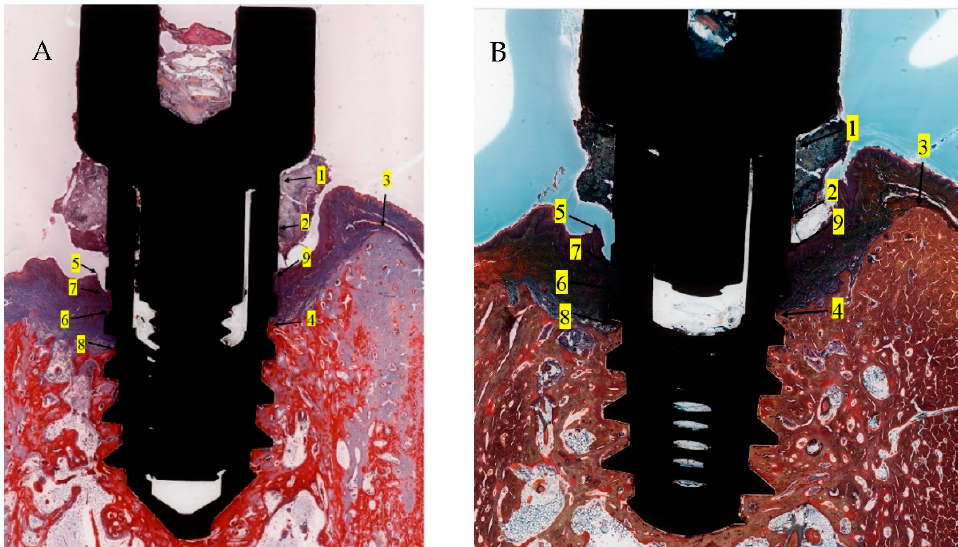
Figure 7. Histomorphometric landmarks identified on both buccal and lingual aspects in each implant: 1—implant shoulder (IS); 2—implant surface at the level of the bone crest (imp); 3—bone crest, defined as the most coronal point of the bone (BC); 4—bottom of the bone defect (BD); 5—margin of the peri-implant mucosa (PM); 6—the apical termination of the junctional epithelium (aJE); 7—the coronal level of the infiltrated connective tissue (cICT); 8—the apical extension of the infiltrated connective tissue (aICT); 9—the most apical extension of the submarginal biofilm that was interposed between the implant and the pocket epithelium of the peri-implant mucosa (aPlaque). (Implant #5, mirroring sections, ( A )—Masson Goldner Anilin blue stain, ( B )—Movat Pentachrome stain, original magnification ×